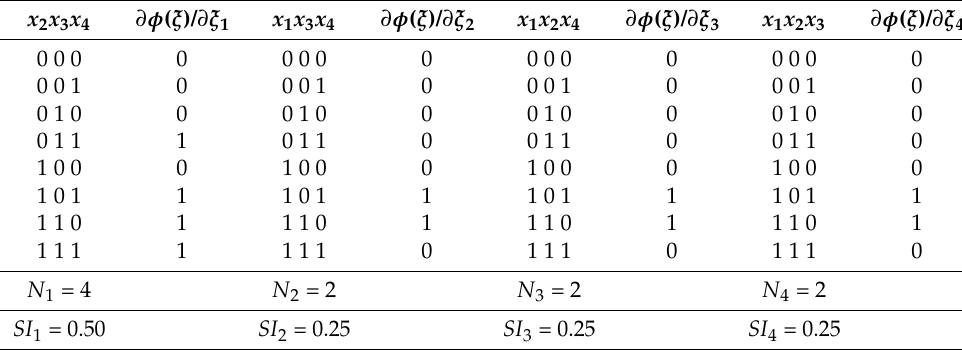
Table 5. Logical derivatives of the structure function.